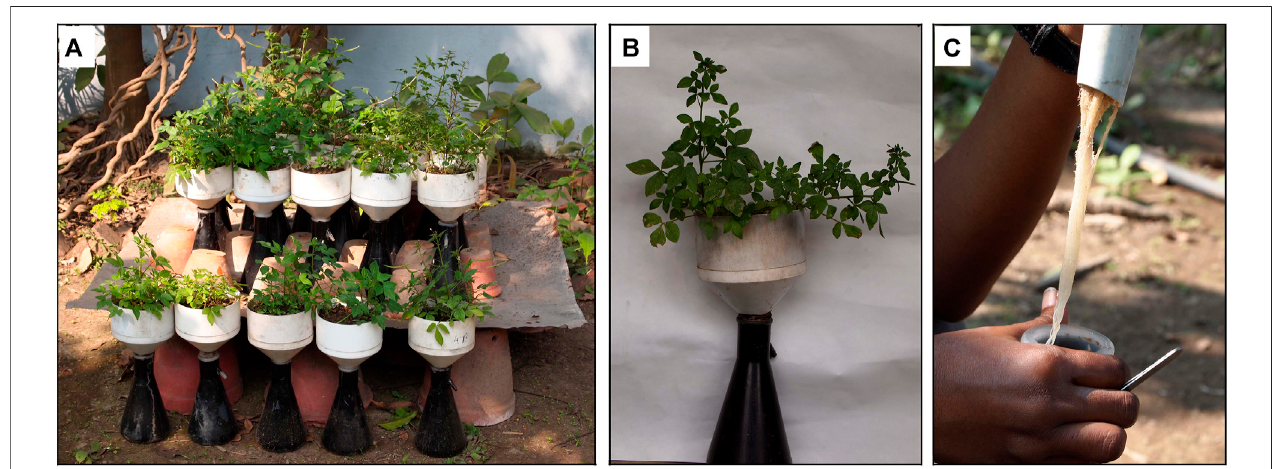
FIGURE 1 | Collection of root exudates from Cleome rutidosperma DC. (A) Total experimental setup, (B) root exudates trapping system, and (C) roots extend downward into the conical fl asks containing distilled water.